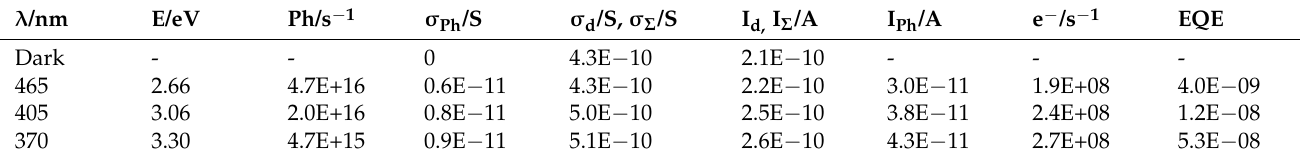
Table 2. Results of DC electrical measurements for TiO 2 P25